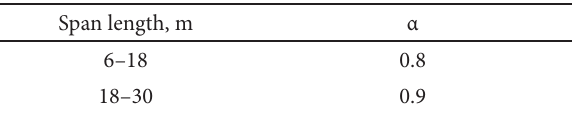
Table 1. The recommended values of adjustment factor α for bridges with spans up to 30 m Span length,